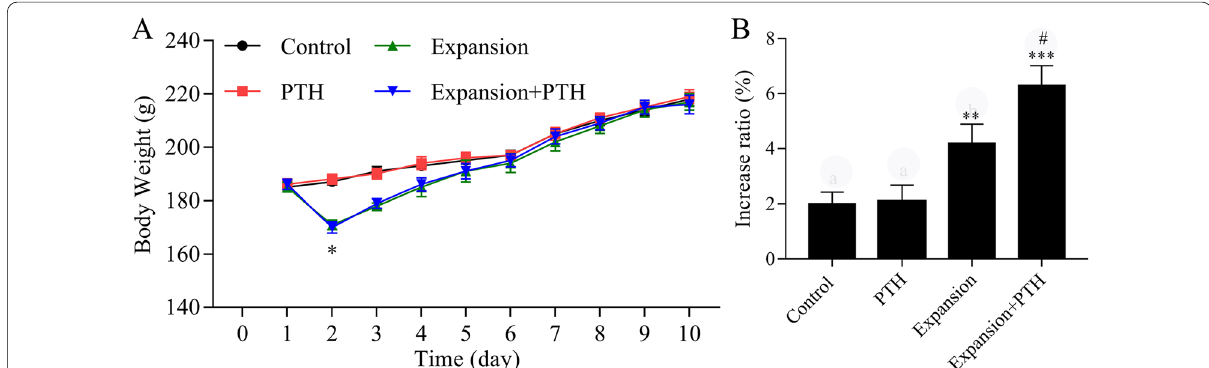
Fig. 3 PTH increased maxillary arch widths of maxillary expansion model rats. The rats were divided into control, PTH, expansion and expansion PTH groups, respectively. A The body weights of rats were detected in each group, * P < 0.05 versus control group. B The maxillary arch + widths of rats were measured in each group. * P < 0.05 versus control group; # P < 0.05 versus expansion